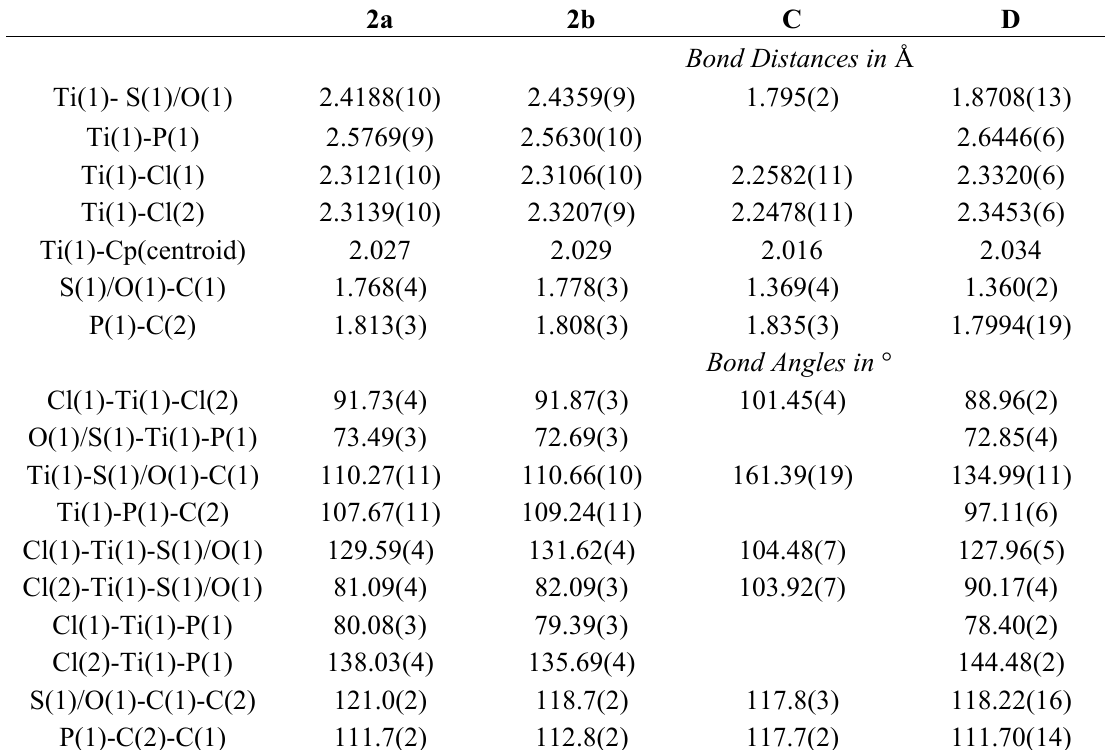
Table 2. Selected Bond Distances (Å) and Angles (deg) for complexes 2a-b and C-D [28] .